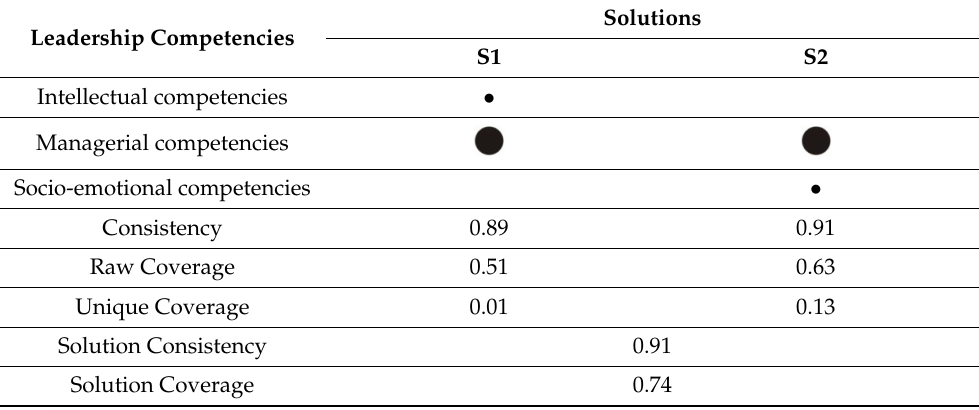
Table 4. Configurations for 4.0 leadership high effectiveness based on the CHP plants research